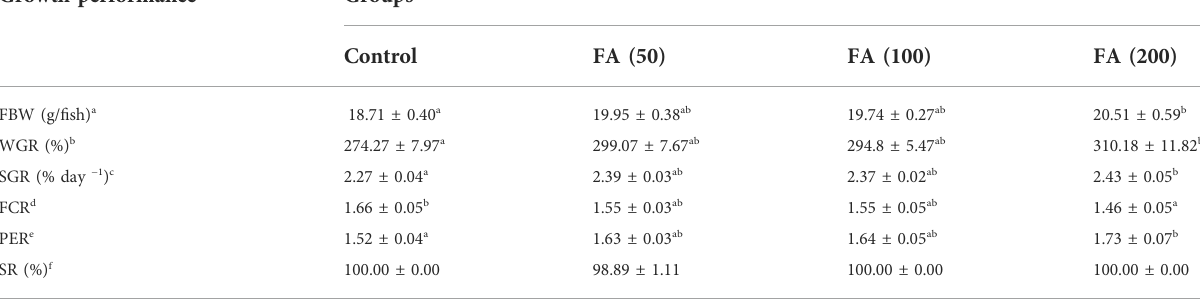
TABLE 3 Growth performance of juvenile grass carp fed diets containing graded levels of FA. Growth performance Groups